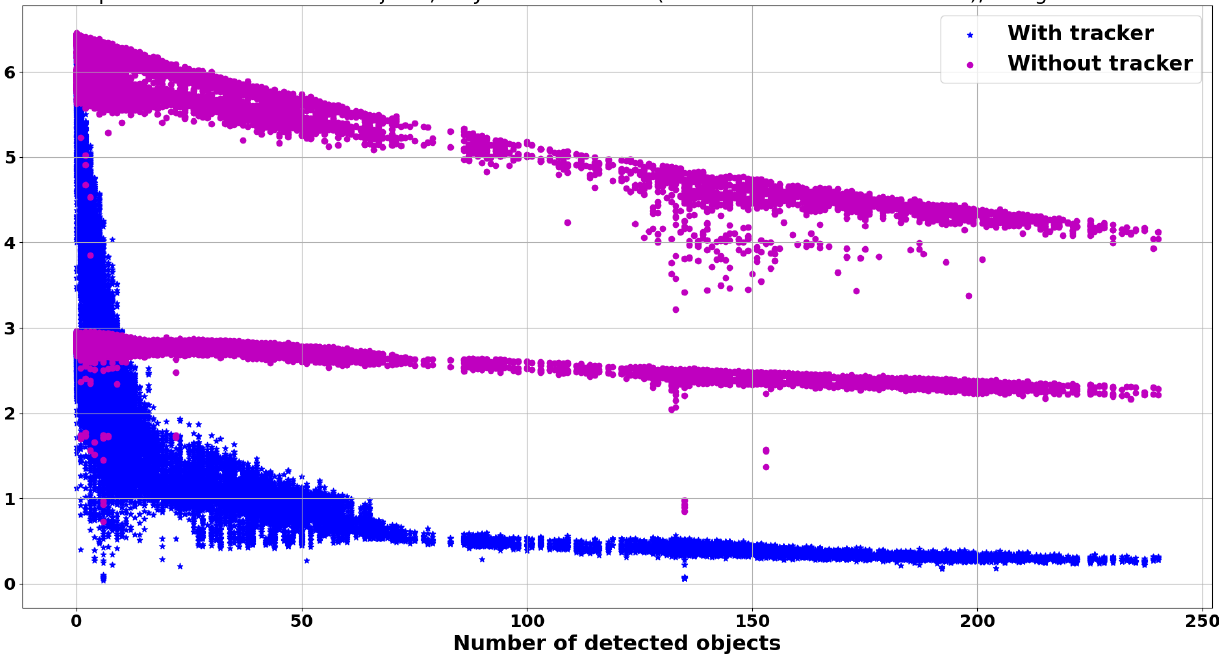
Figure 11. Inference speed (in FPS) per number of detected objects, on Jetson Xavier NX, with an input video resolution of 1920 × 1080, using the TRT version of the YOLOv7 object detection model, when including or excluding the